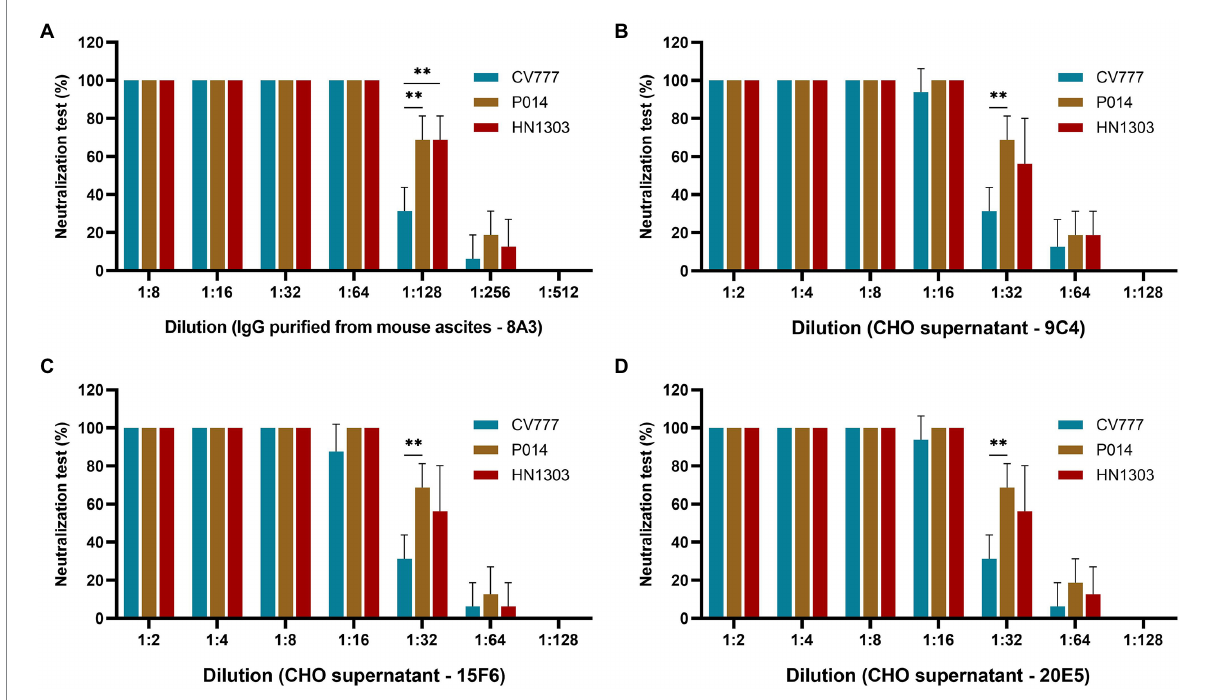
FIGURE 4 Evaluation of the neutralization effect of chimeric IgG/IgA in different genotypes of PEDV strains. The neutralization assay results of purified IgG 8A3 (A) , CHO cell supernatant of 9C4 (B) , 15F6 (C) and 20E5 (D) against PEDV strains CV777, P014 and HN1303. ** p <